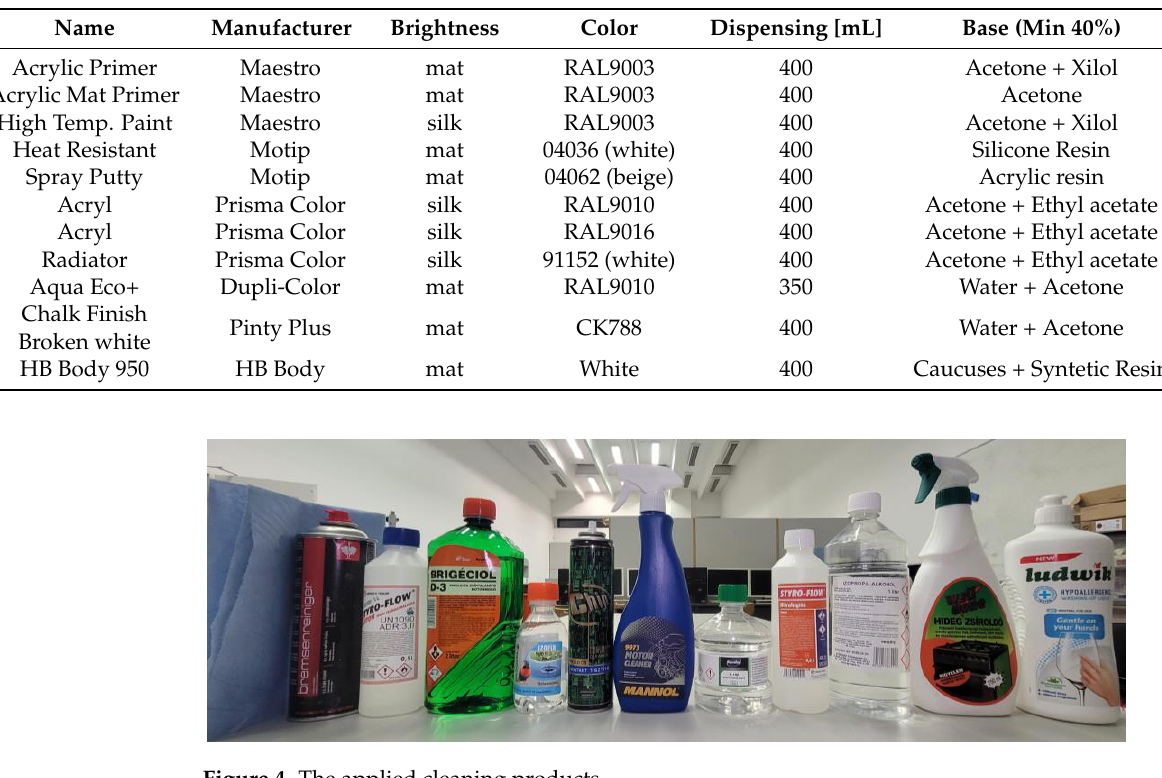
Figure 4. The applied cleaning products.